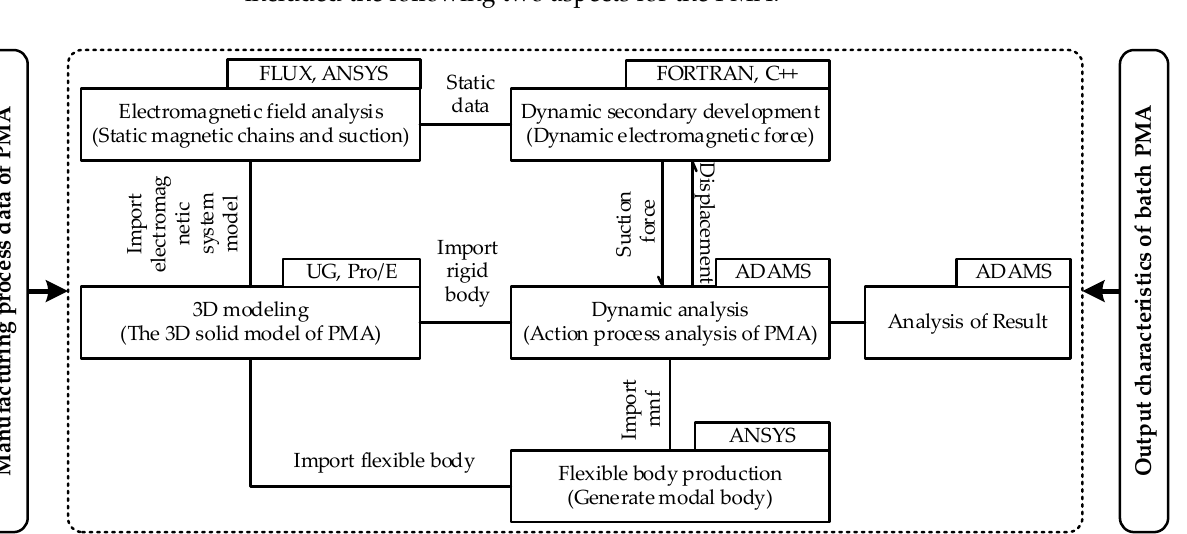
Figure 3. The simulation modelling procedure of the PMA.